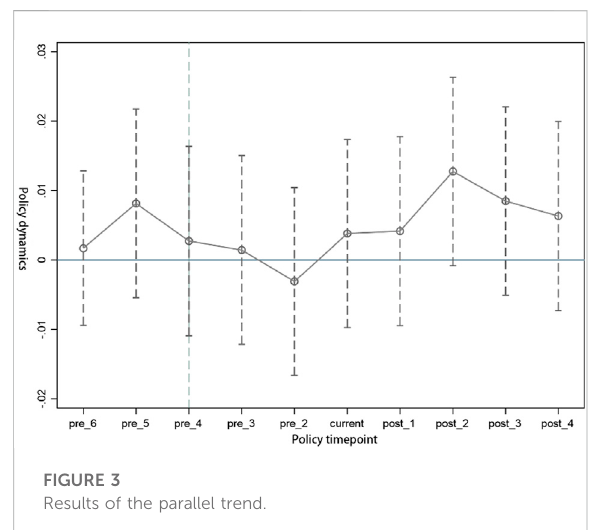
SD represents standard deviation.